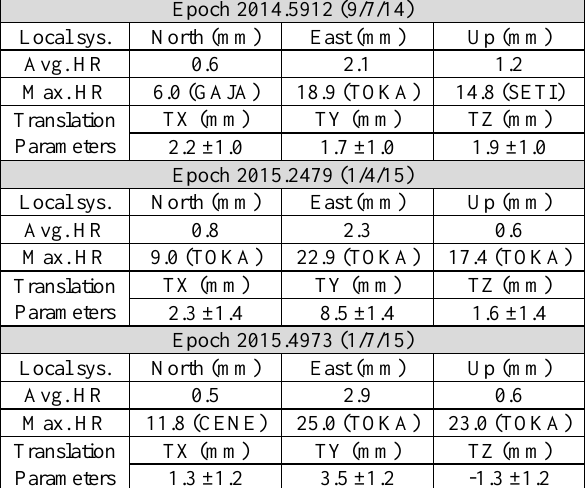
Table 8. The average and maximum Helmert residual in local system and the translation values for each of the validation epochs for Peninsular Malaysia